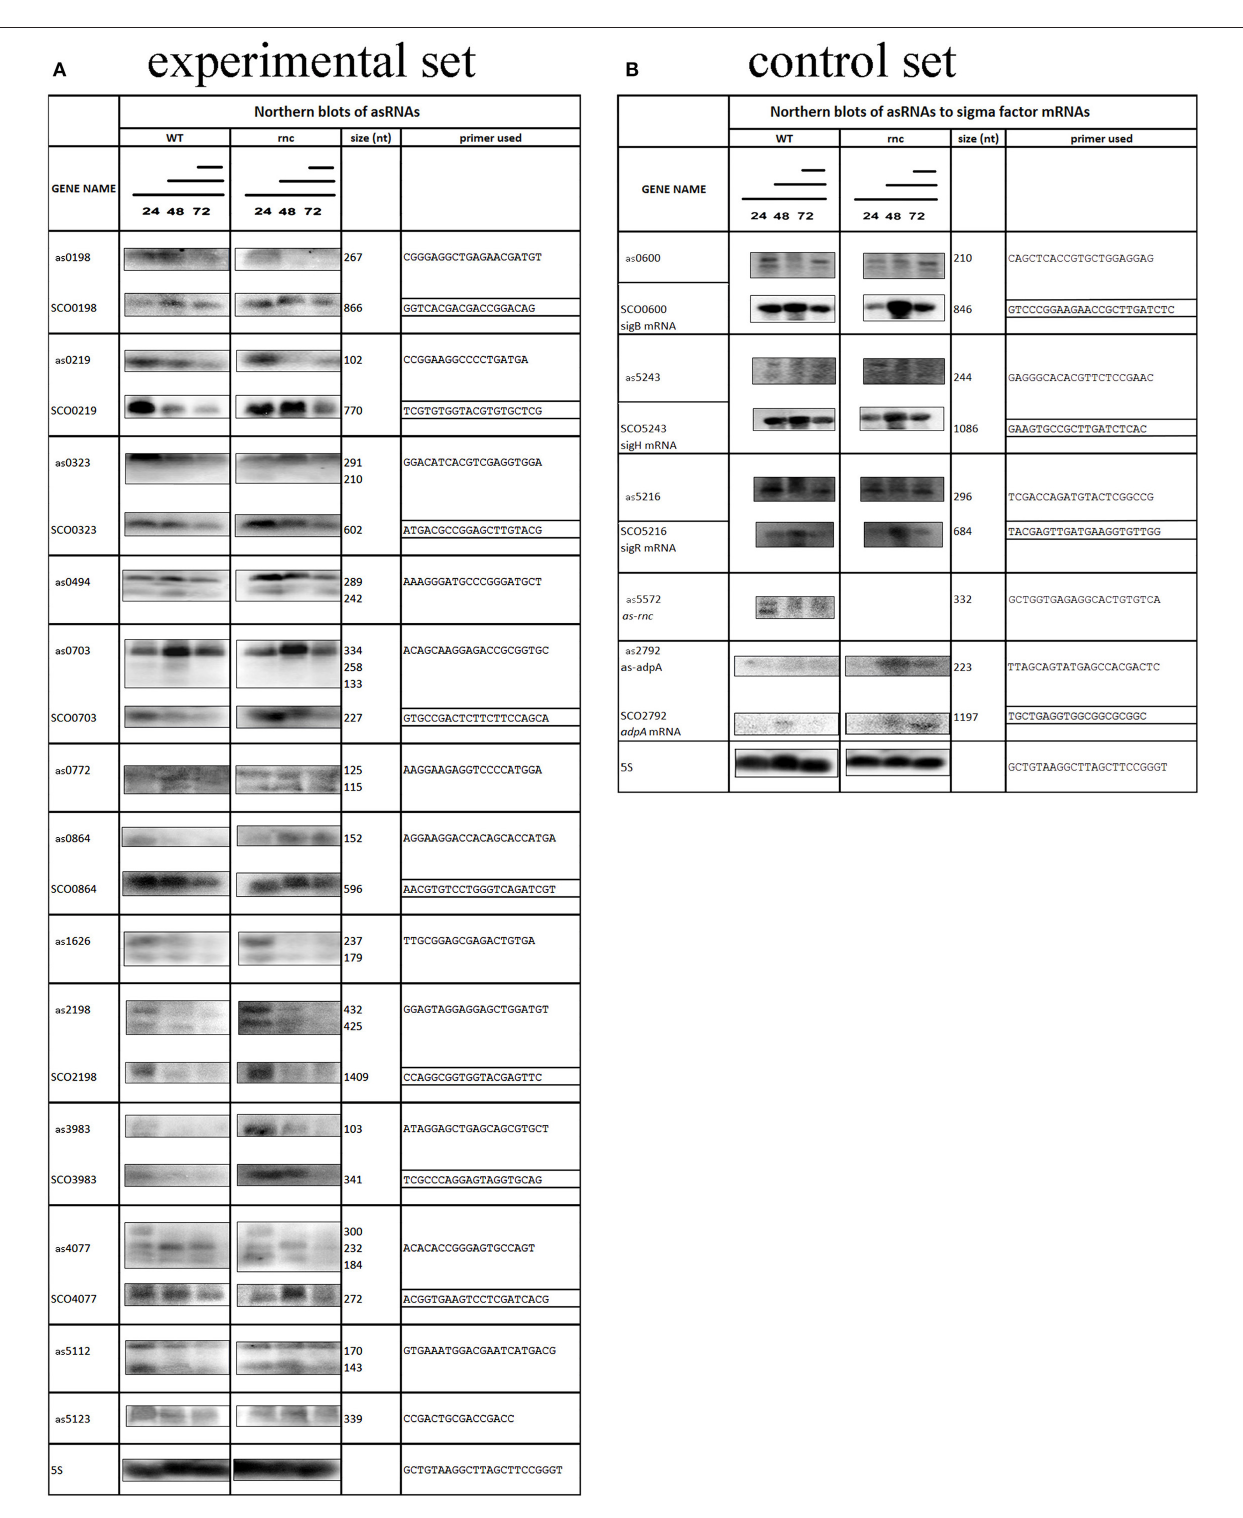
Frontiers in Microbiology | www.frontiersin.org